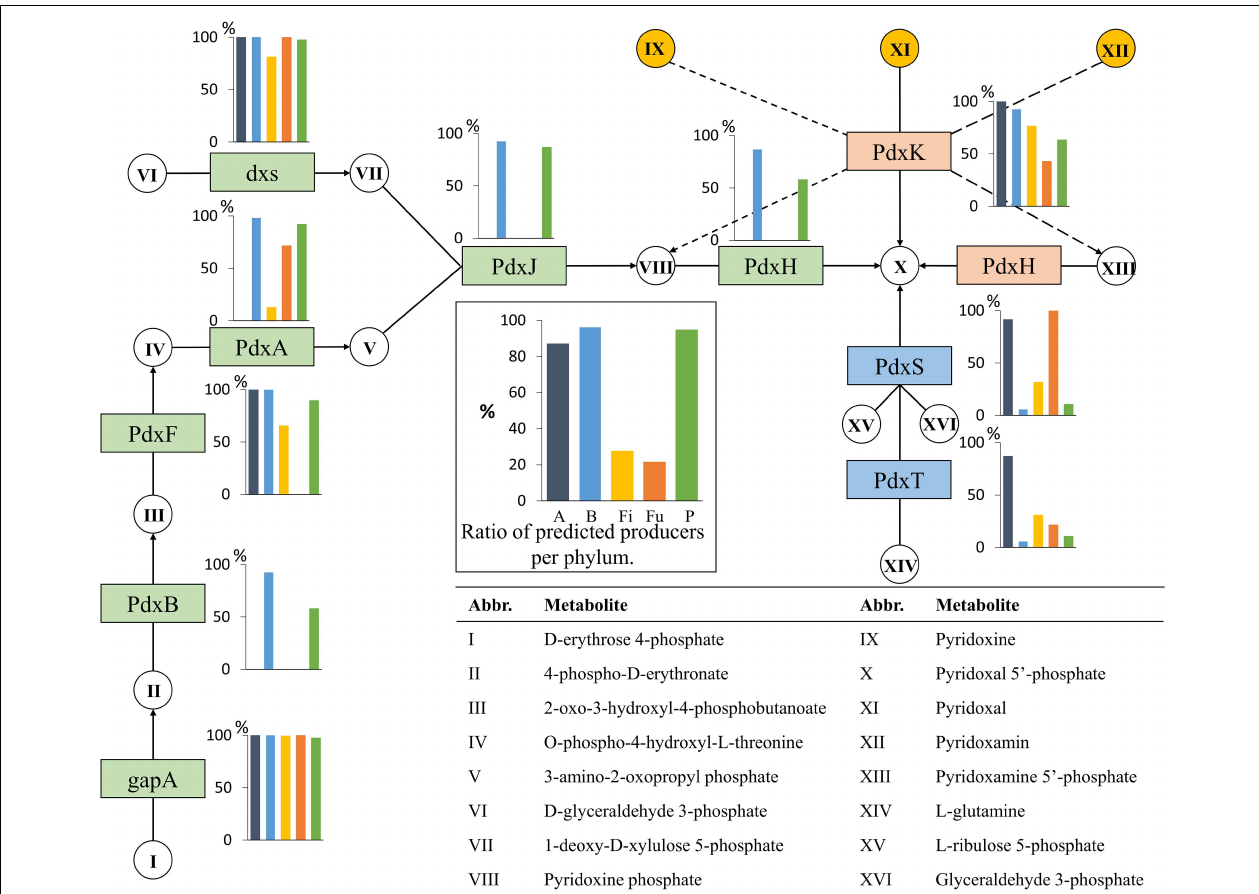
FIGURE 6 | Pyridoxine biosynthesis. The pyridoxine biosynthesis subsystem contains 11 functional roles (Supplementary Table 2) and 16 metabolites. Refer to Figure 1 for figure descriptions.